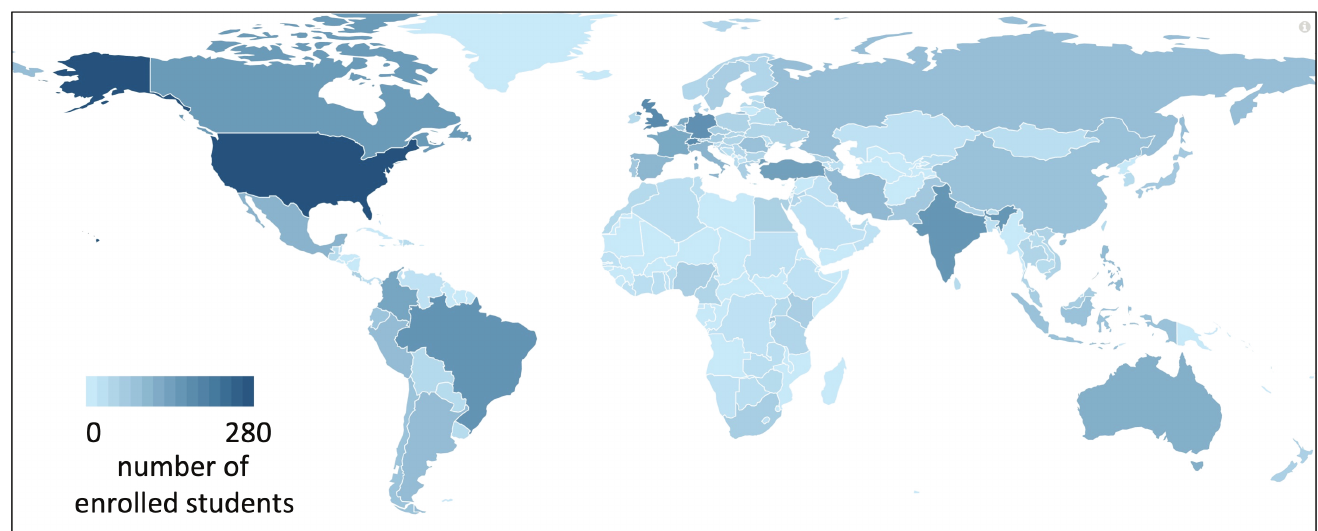
Figure 1: Origin of the students in the Landscape Ecology MOOC of 2019 (Total participants 990-1390 depending on the point in time in the